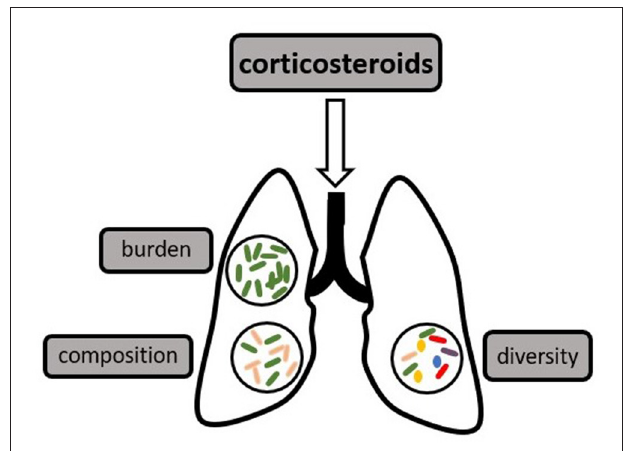
FIGURE 1 | Parameters of a microbiome: burden, composition, and